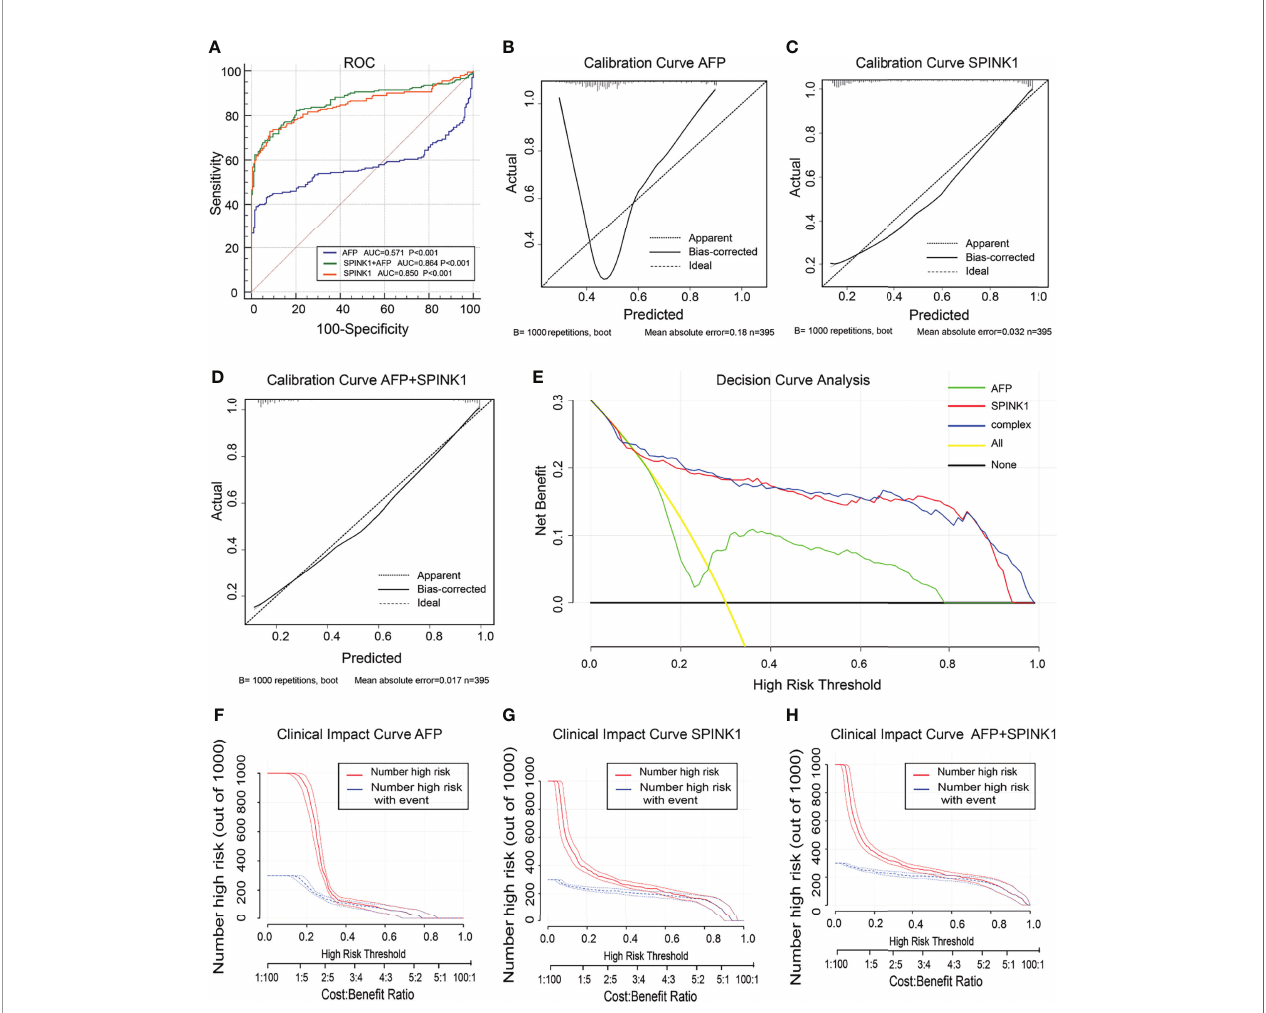
FIGURE 3 | Discrimination and calibration of hepatocellular carcinoma (HCC) prediction models through transcriptomics analyses in the validation dataset no. 1. (A) Receiver operating characteristic (ROC) curves and area under the curve (AUC) in the SPINK1 , SPINK1 plus alpha-fetoprotein (AFP), and AFP models. (B – D) Calibration curves of AFP (B) , SPINK1 (C) , and SPINK1 +AFP (D) . (E) Clinical net bene fi ts shown by decision curve analysis (DCA) of SPINK1 , SPINK1 +AFP, and AFP. (F – H) Comparison of the clinical bene fi ts obtained from the clinical impact curve (CIC) analysis of each detection